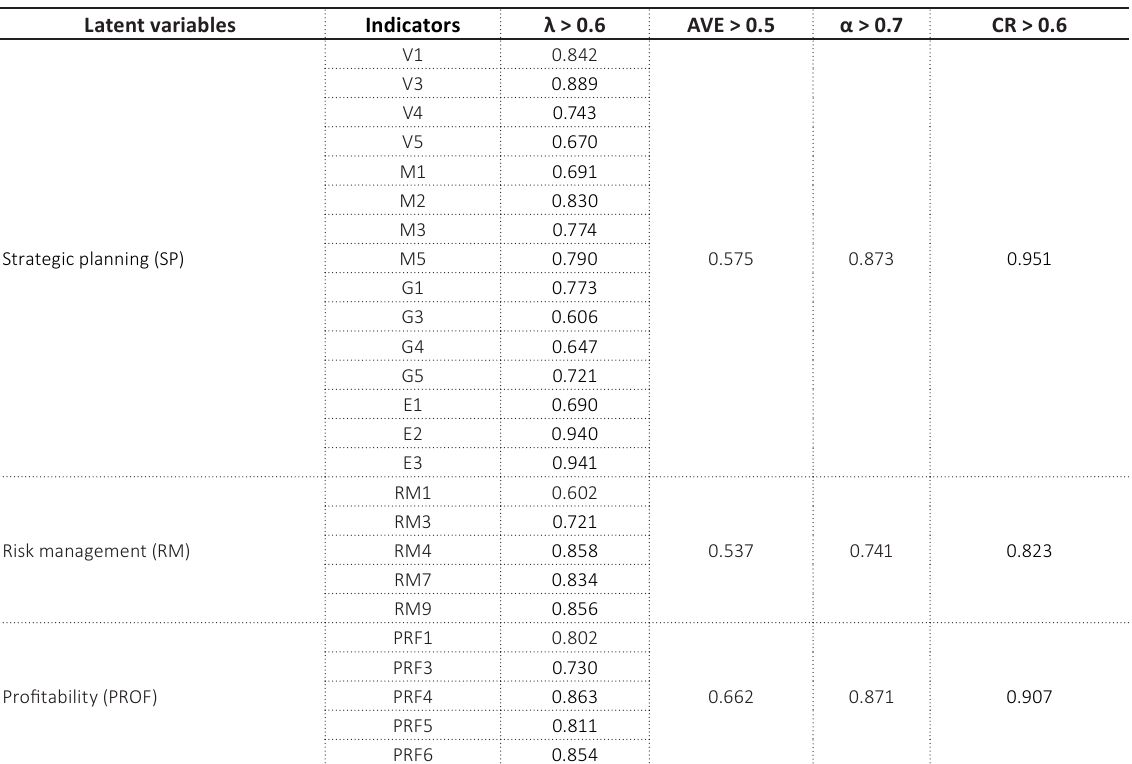
Table 1. Convergent validity and